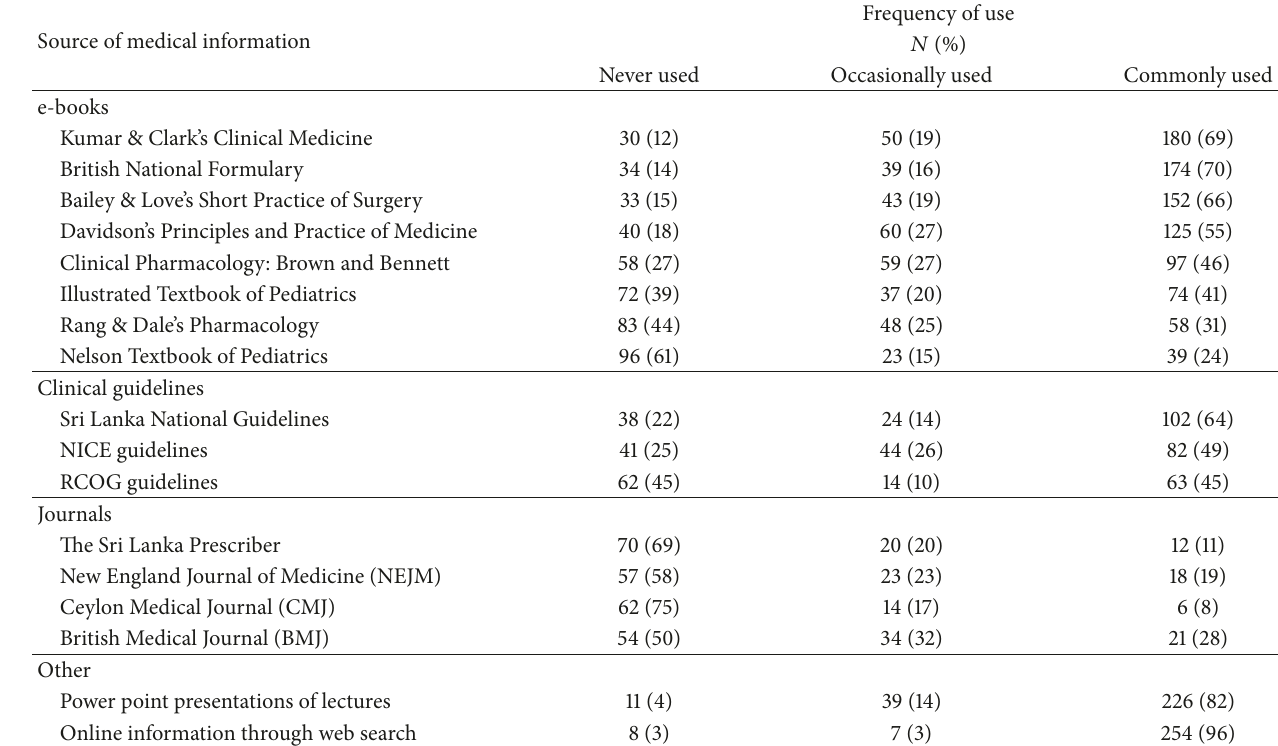
Table 1: Different electronic sources of medical information (e-books, guidelines, journals, power point presentations, etc.) used by medical UGs via